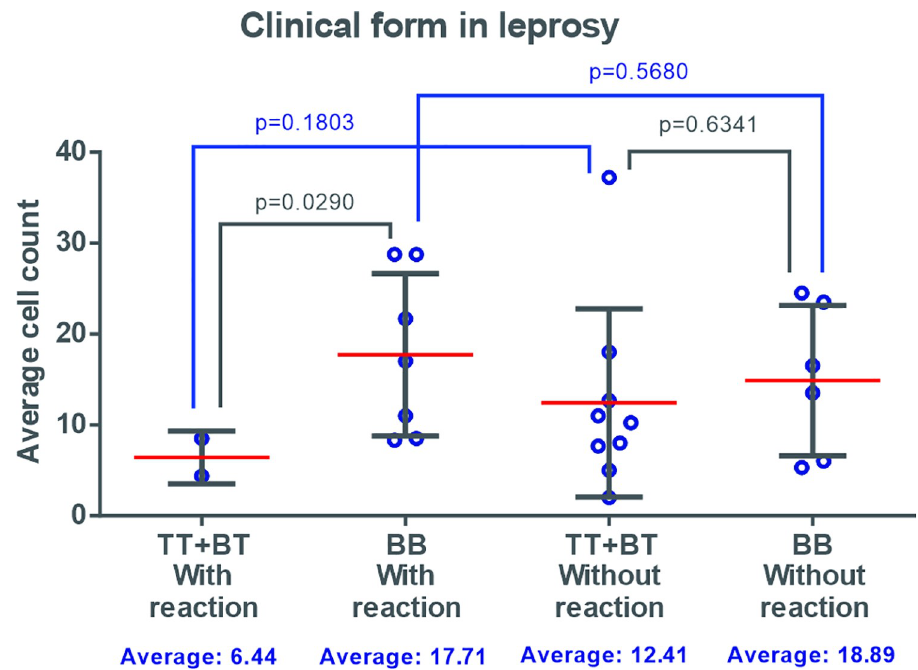
Fig 8. Density of cells expressing FOXP3 in patients with leprosy, according to clinical form � and the presence of reverse reaction. � Clinical forms: borderline borderline (BB), borderline tuberculoid (BT) and tuberculoid (TT).